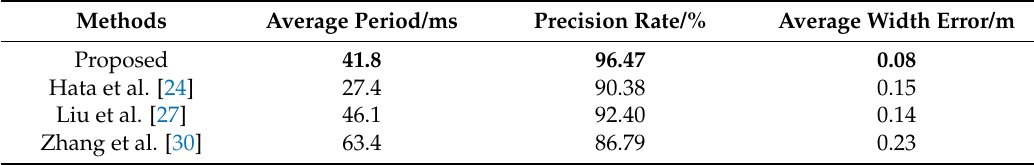
Table 2. The comparison between different curb detection algorithms.